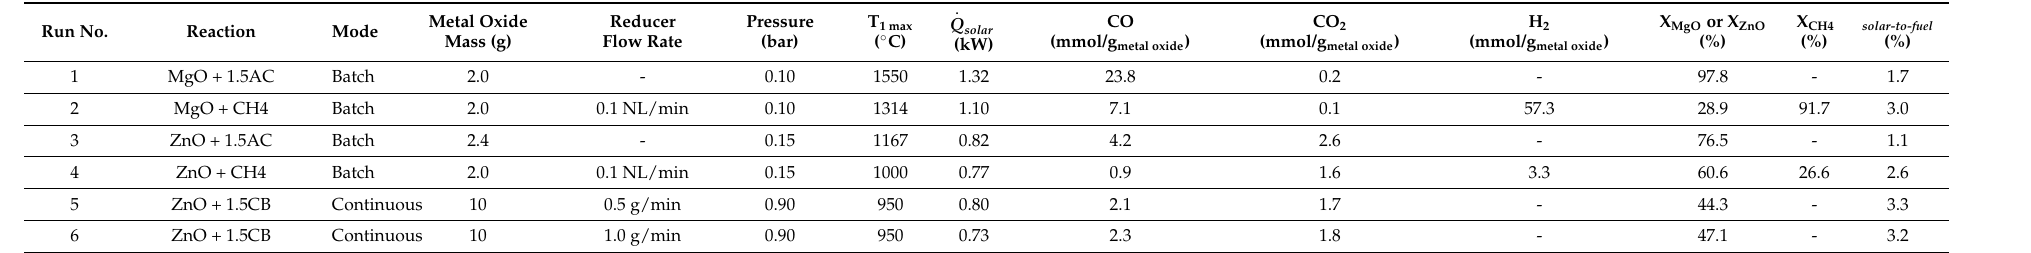
Table 1. Operating conditions and solar reactor performance